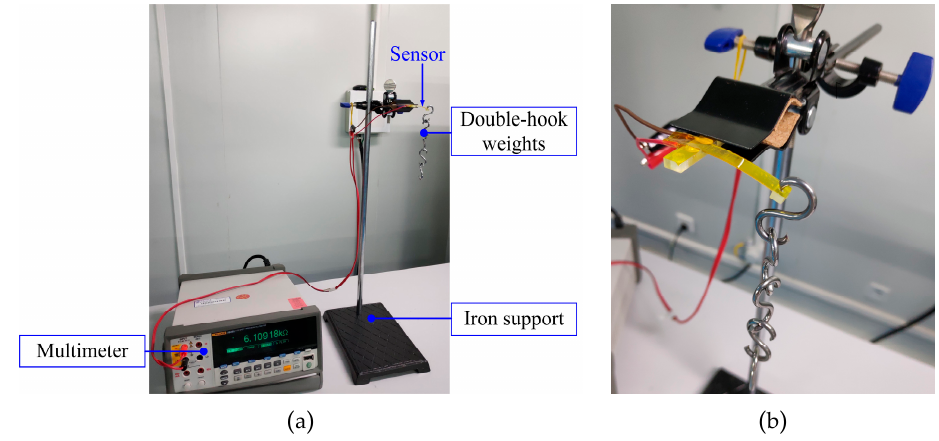
Figure 13. Pictures of the experimental setup: ( a ) Composition of the experimental setup; ( b ) details of the experimental setup.